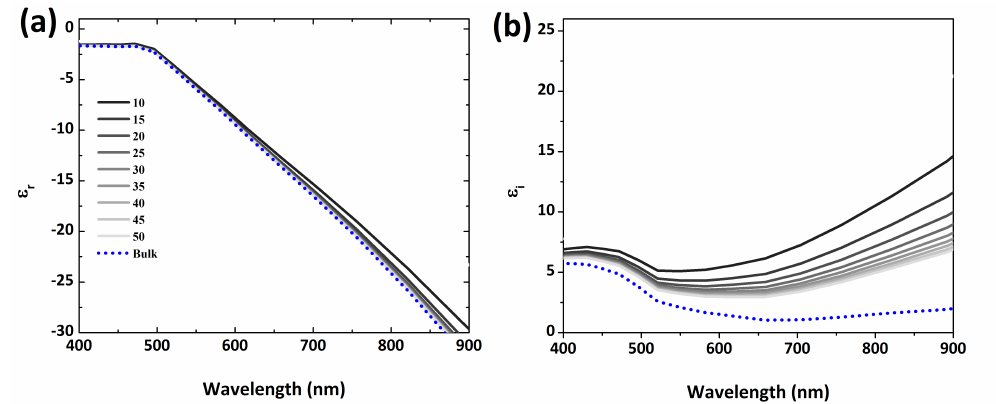
Figure 3. The dielectric function of gold nanoparticles ( a ) real part and ( b ) imaginary part of permittivity. The radius of particle is tuned from 10 nm to 50 nm with a step of 5